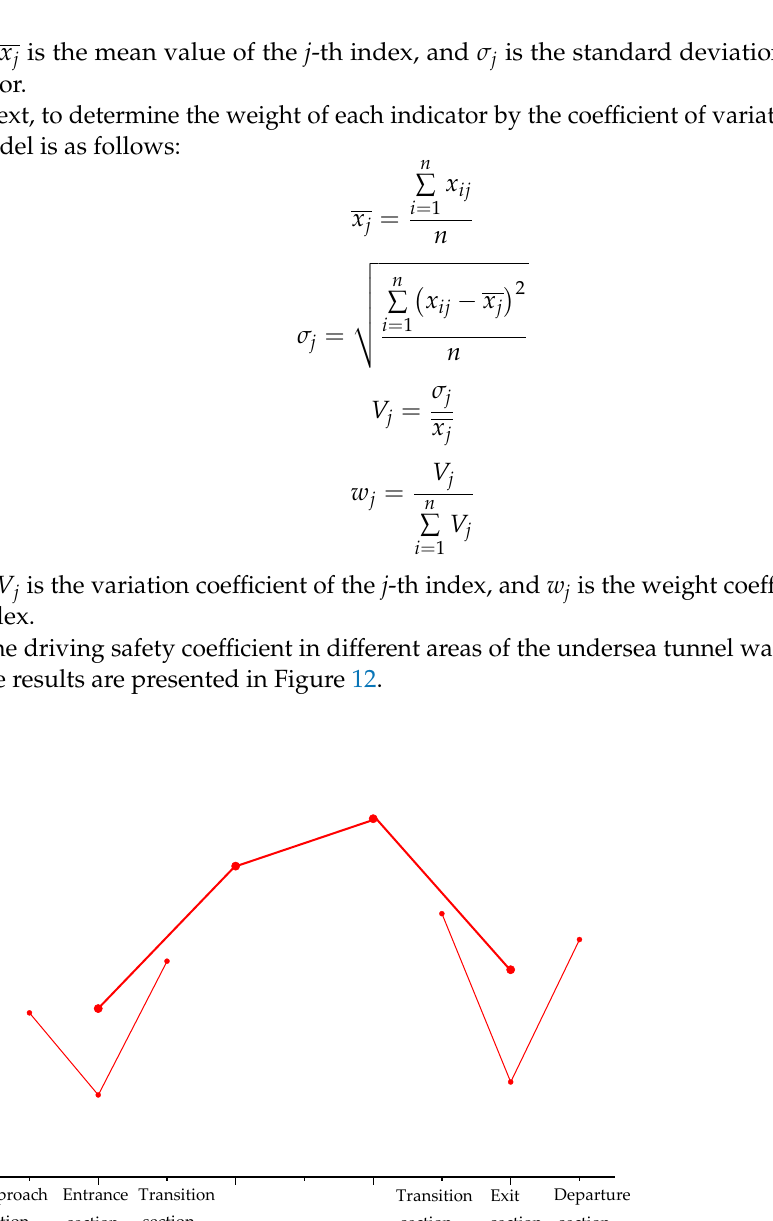
Table 2. Driving safety coefficient in different areas of the undersea